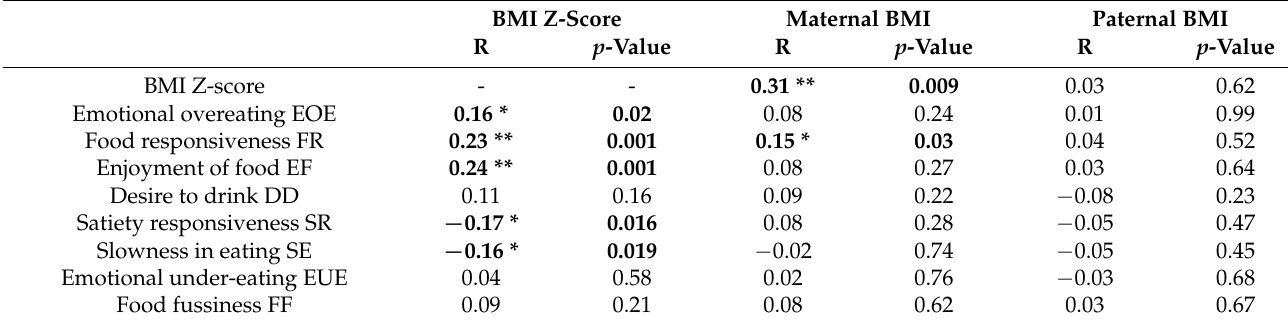
Table 8. Correlations between CEBQ scales, BMI Z-score, maternal BMI and paternal